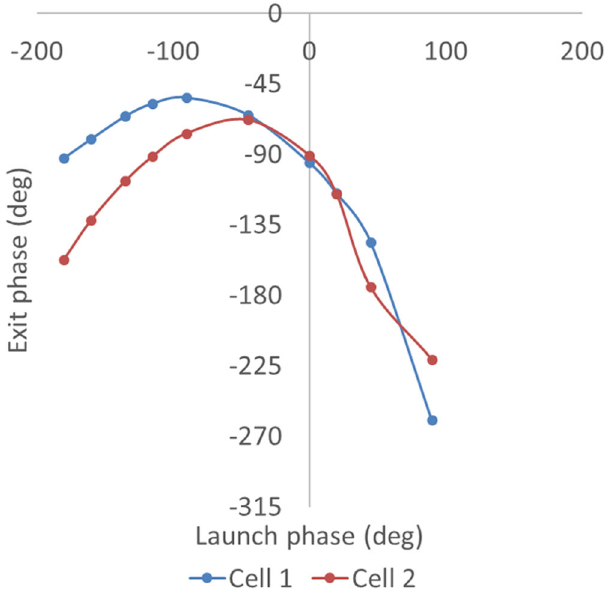
FIG. 5. Arrival phase at the exit of the first and second cells as a function of the electron launch phase from the cathode for the optimized cell